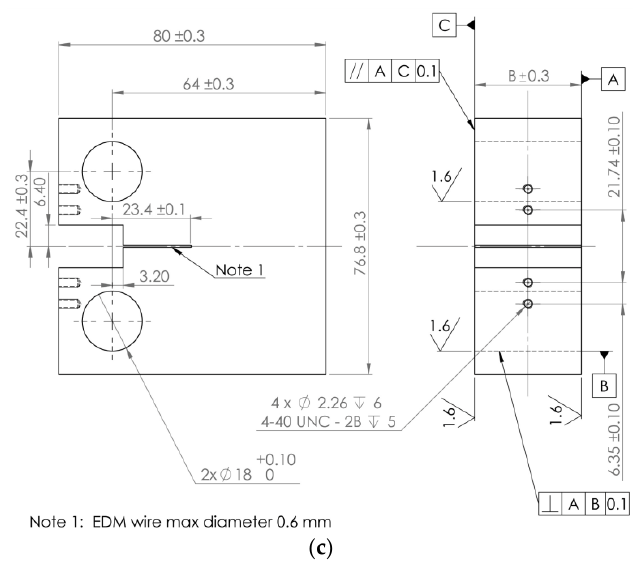
Figure 2. Geometry of the specimens used in the present experimentation. ( a ) Dog-bone samples used for monotonic tensile tests. ( b ) Uniform-gage test section samples used in rotating bending fatigue tests. ( c ) Compact tension C(T) specimens used in fracture mechanics tests. Dimensions are given in mm. The thickness B of the C(T) specimens is equal to 10 mm and to 32 mm for fatigue crack growth rate and fracture toughness tests, respectively.